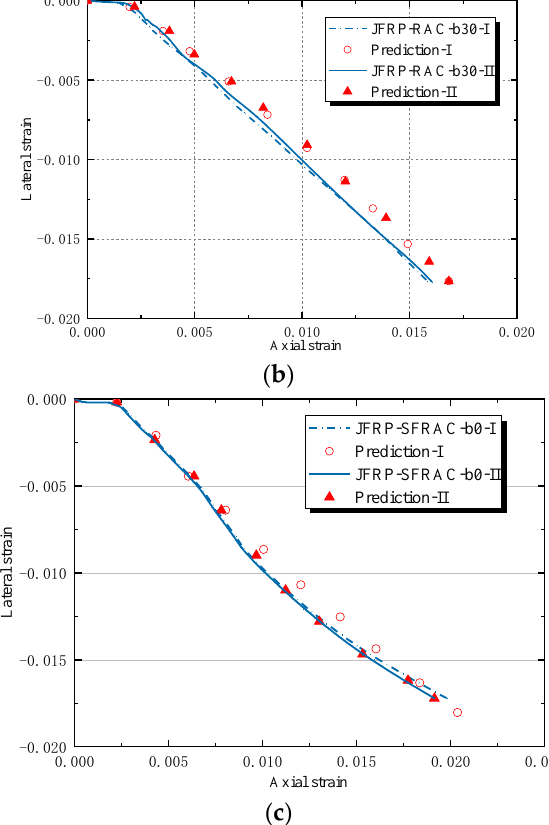
Figure 13. Comparison of Teng’s lateral strain-axial strain model: ( a ) JFRP–RAC-b0, ( b ) JFRP–RAC-b30 and ( c ) JFRP – SFRAC-b0.